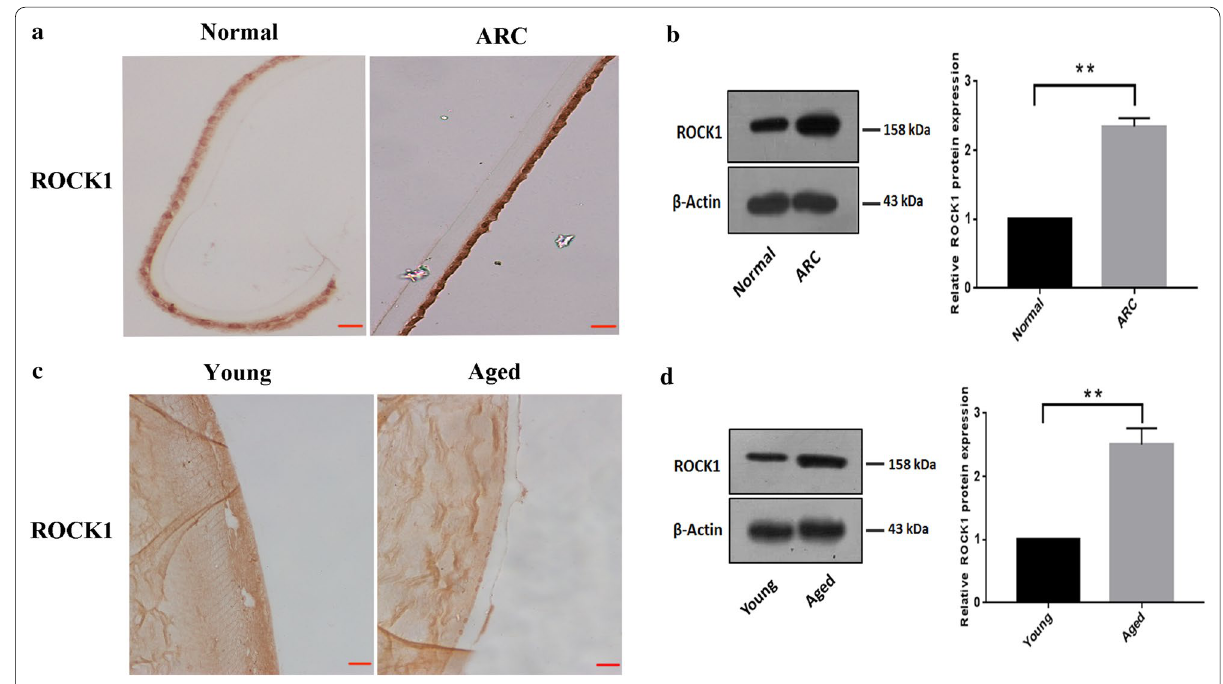
Fig. 3 Up-regulation of ROCK1 in the lens epithelial cells from age-related cataract patients and the old mice respectively. a Up-regulation of ROCK1 in LECs from cataract patients compared to the control group. Lens sections were immunostained to assess the ROCK1 expression in the LECs from the patient and control group. Scale bar: 20 µm. b Western blotting estimated that the protein level of ROCK1 between the patient and the control group. The 100–250 kDa blot was retained by horizontal shear and incubated with the ROCK1 antibody. The 35–50 kDa blot was retained by horizontal shear and incubated with the β-actin antibody. c Lens sections were immunostained to assess the ROCK1 expression in the LECs from young and old mice, Scale bar: 20 µm. d Western blotting estimated that the protein level of ROCK1 between young and old mice, β-actin was used as an internal reference control. The 100–250 kDa blot was retained by horizontal shear and incubated with the ROCK1 antibody. The 35–50 kDa blot was retained by horizontal shear and incubated with the β-actin